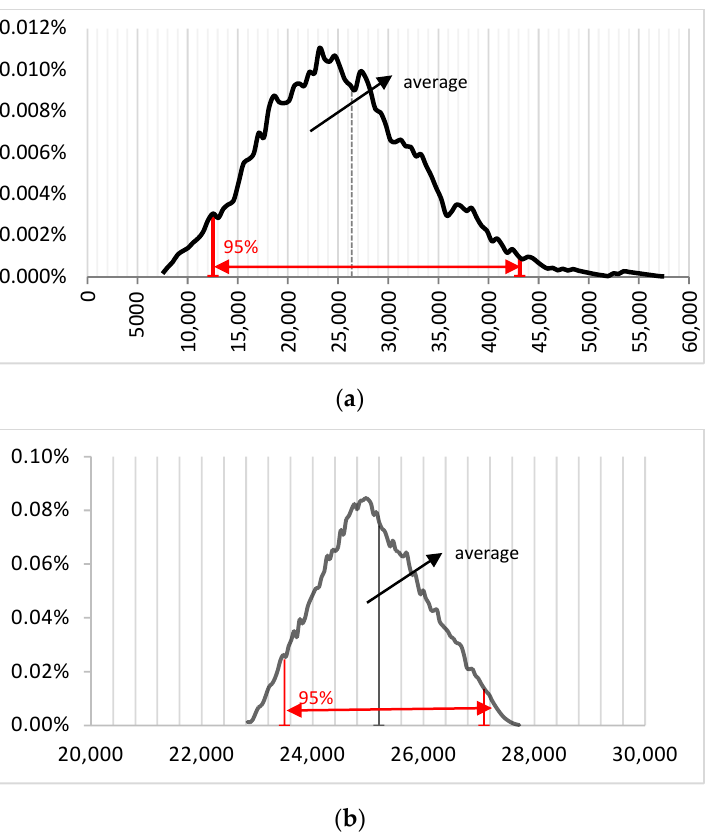
Figure 6. Distribution of revenues ( a ) and costs ( b ) of organic aloe vera crops per year (source: own elaboration).